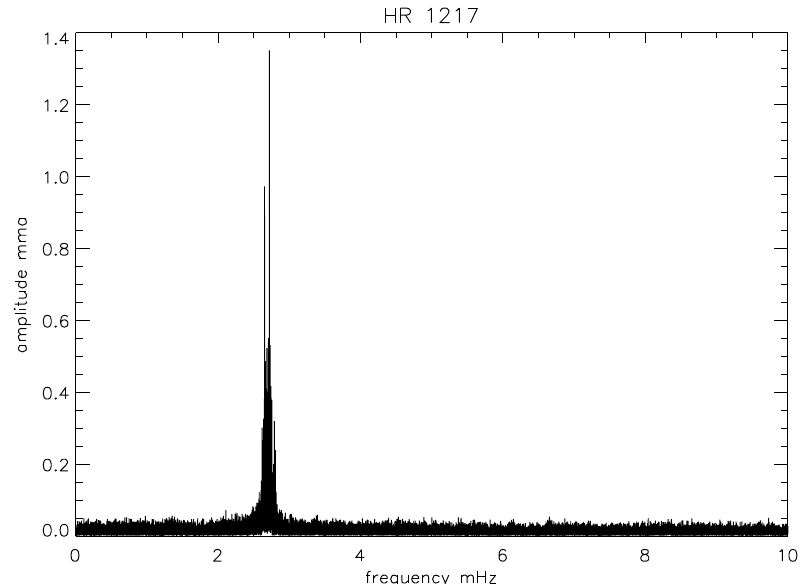
Fig. 1. FT of a stringently selected, 29.5% duty cycle subset of the XCov20 data for HR 1217. The highest noise peaks are at 50 μ ma and the formal errors on the determined amplitudes are 14 μ